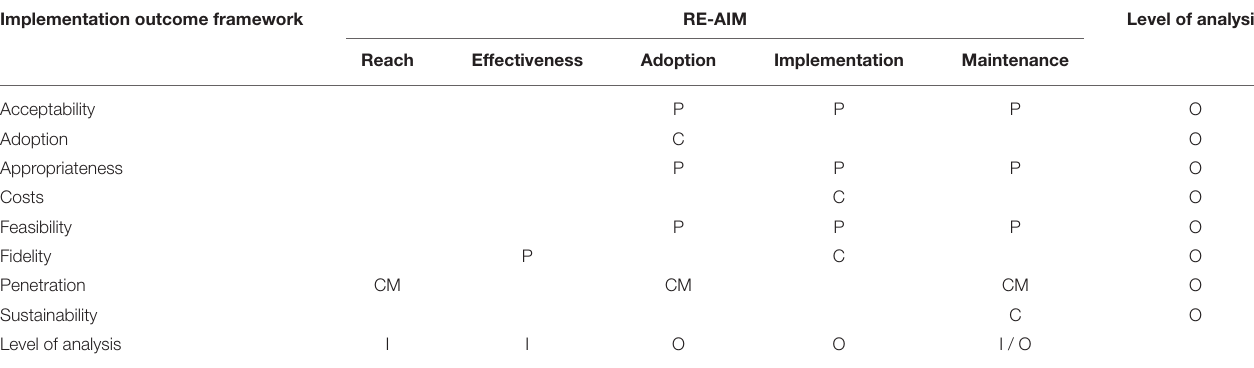
TABLE 2 | Cross-tabular comparison of RE-AIM and IOF outcomes. Implementation outcome